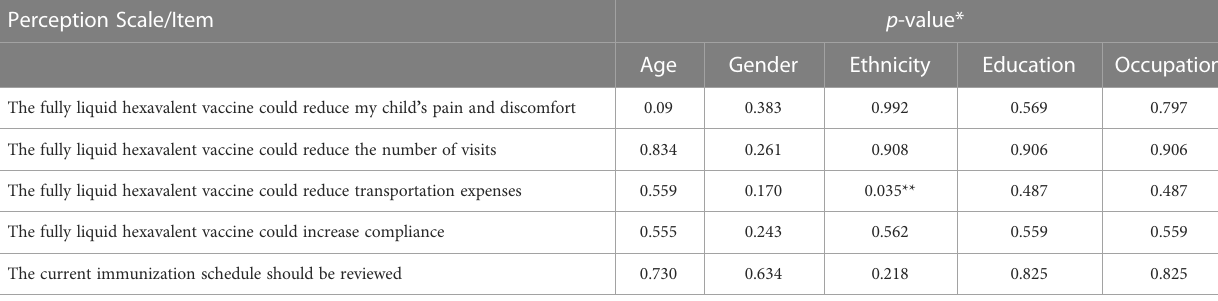
TABLE 2 Factors associated with parents ’ fully liquid hexavalent vaccine perception ( n = 346). Perception